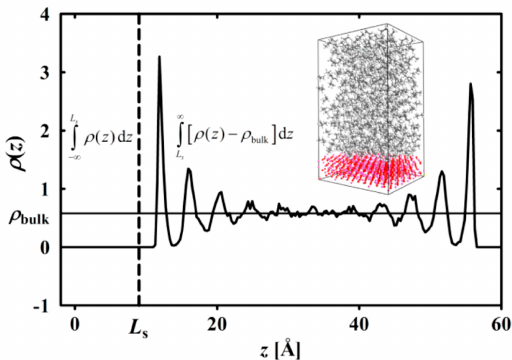
Figure 7. Number density profile from atomistic MD simulations. Molecular center-of-mass of a particular bead is used in computation of the profiles. Vertical line is the location of the substrate surface and defines the integration boundaries. A pictorial representation of the atomistic simulation box snapshot is given as the inset picture. Reprinted with permission from Kacar et al. [203]. Copyright 2016 American Chemical Society.